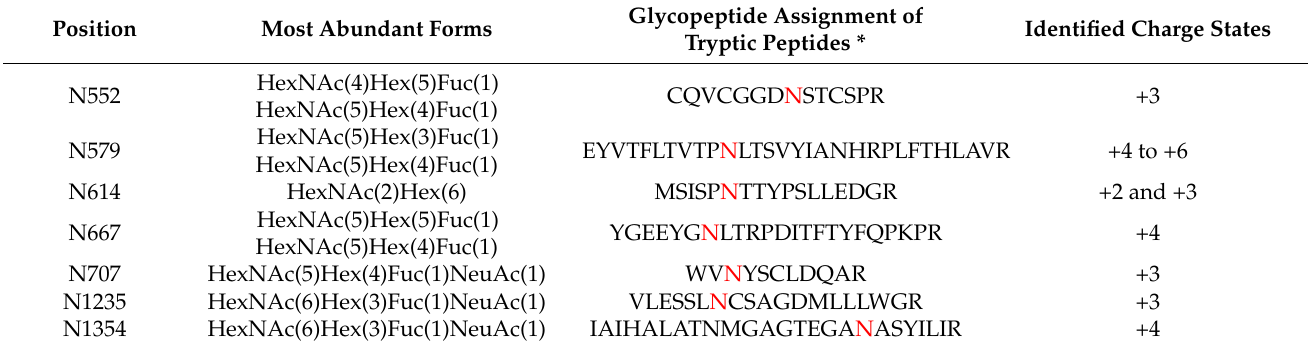
Table 3. N -glycosylation data of flask-derived V5-tagged purified rADAMTS13.